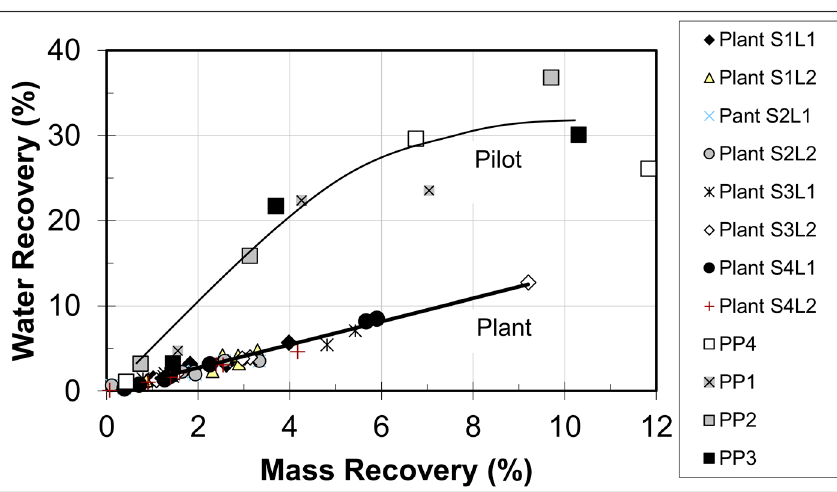
Figure 5. Water recovery versus mass recovery for the plant and pilot tests.